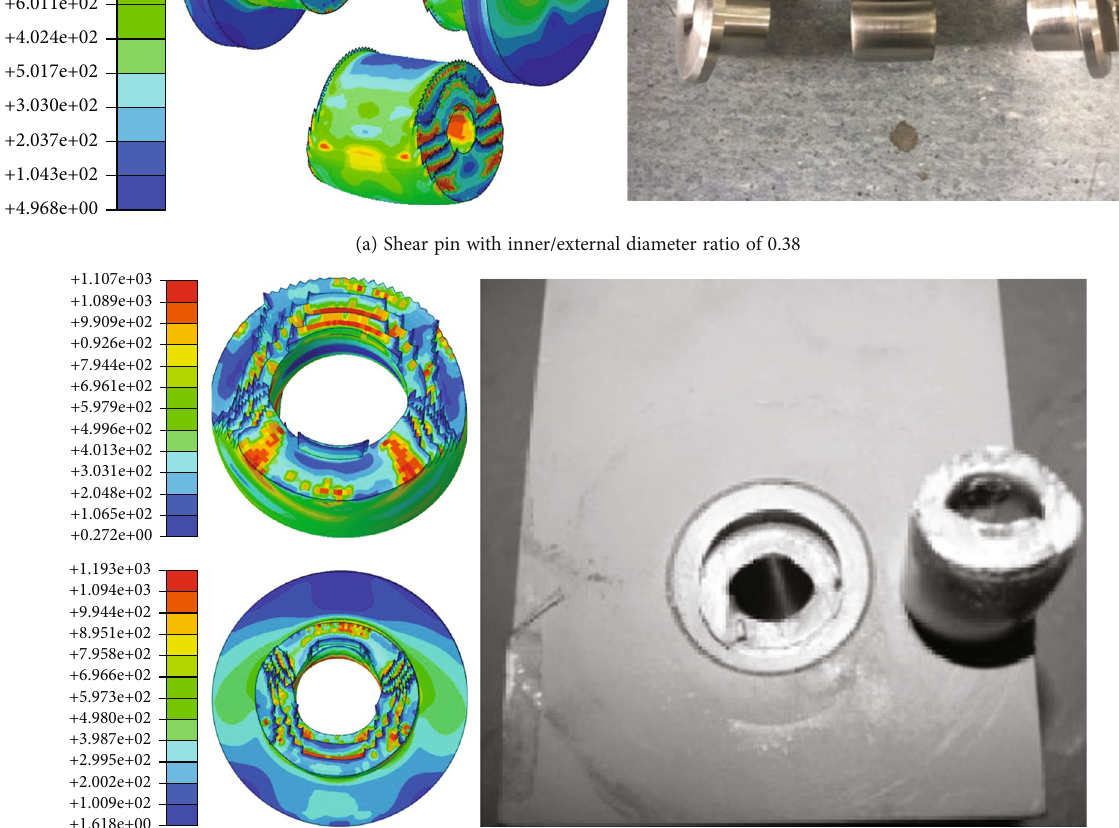
Figure 4: Comparison of simulation results and test